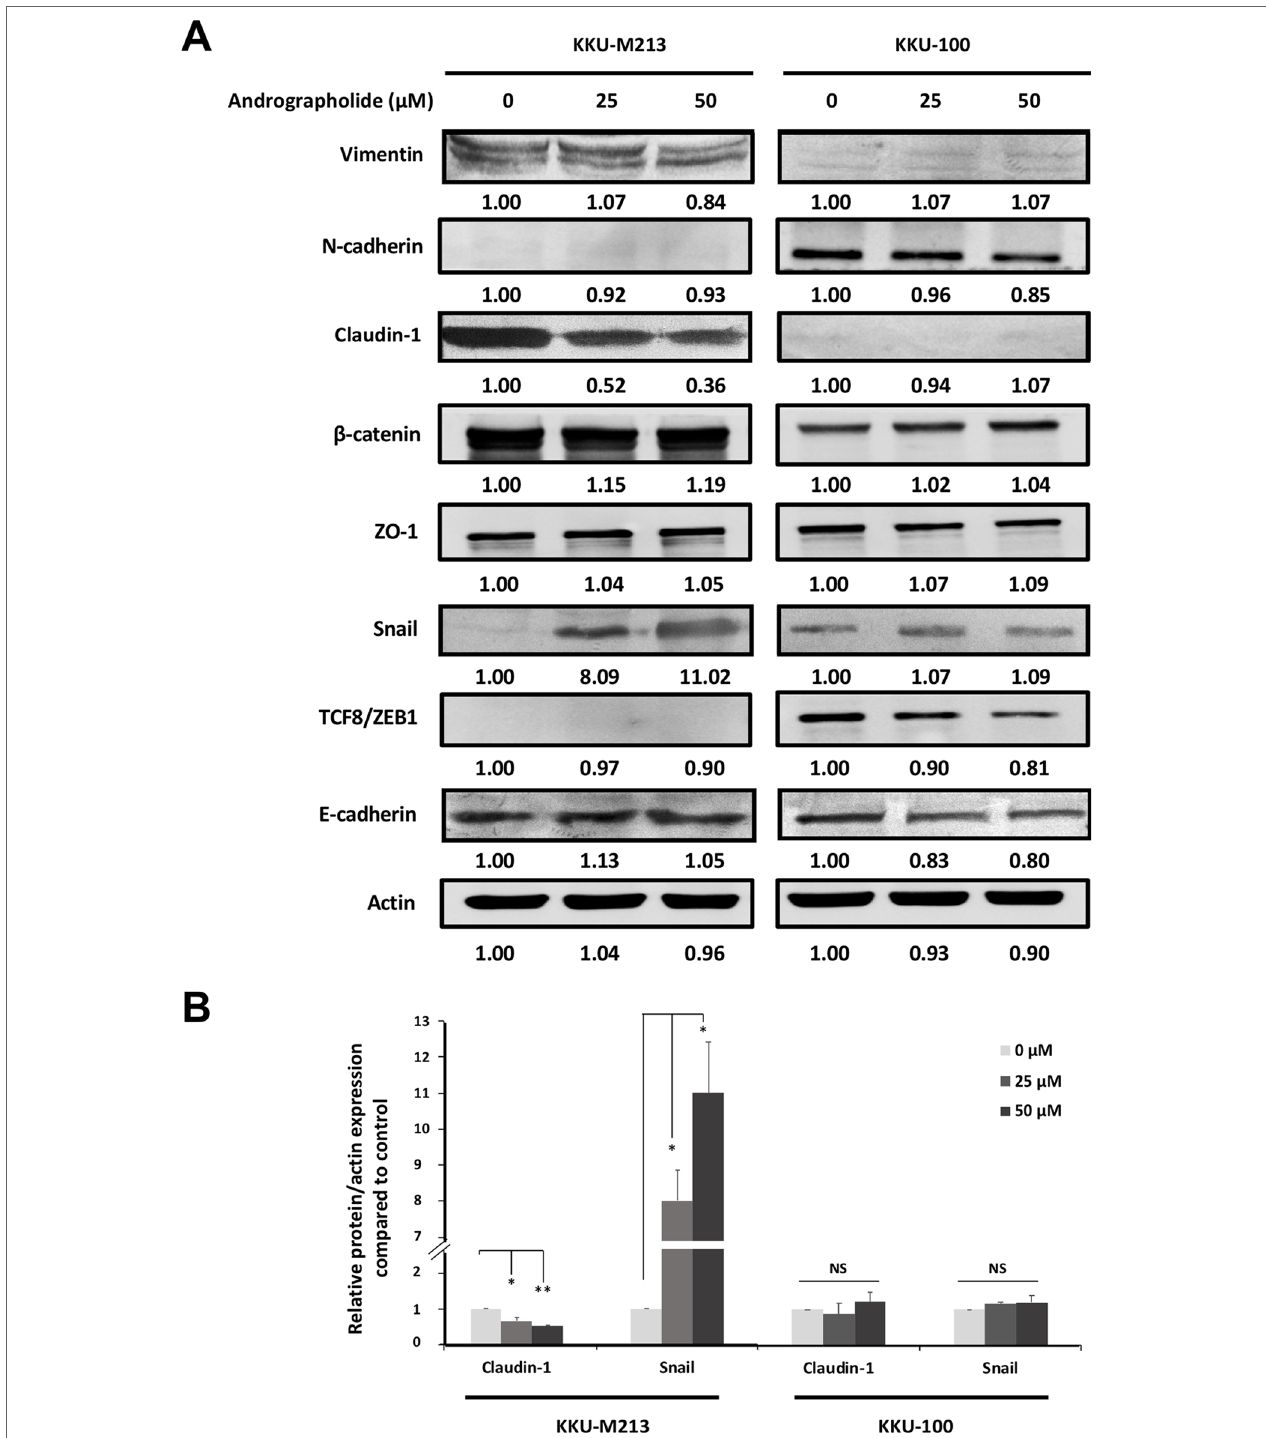
FIGURE 2 | Effects of andrographolide on the expression of epithelial–mesenchymal transition (EMT) proteins in CCA cells. (A) KKU-M213 and KKU-100 cells were treated with 0, 25, and 50 µM of andrographolide for 24 h prior to harvesting proteins. The expression of EMT-related proteins was evaluated using Western immunoblotting with actin as internal control. Representative results of three independent experiments are shown. The level of protein expression was quantified by intensitrometric analysis relative to actin as ratios to the untreated control. (B) The graphs present the expression of claudin-1 and Snail in KKU-M213 and KKU-100 upon the treatment of andrographolide. The results of bar graph are represented by the average of relative intensity compared with that of the control. Data were presented as mean ± SE, which were derived from three independent experiments, * p < 0.05, ** p <